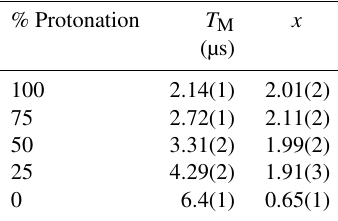
Table 2. The phase memory time, T M , and the stretching exponent, x , obtained from fitting stretched exponential decays to the two- pulse echo decays (25K) of the 3-maleimido-proxyl samples with different degrees of solvent